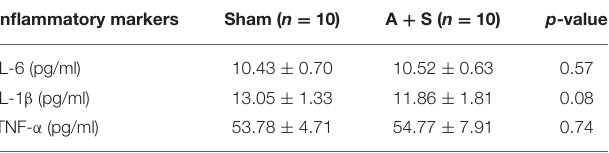
TABLE 3 | Effects of anesthesia/surgery on serum inflammatory markers. Inflammatory markers Sham ( n =